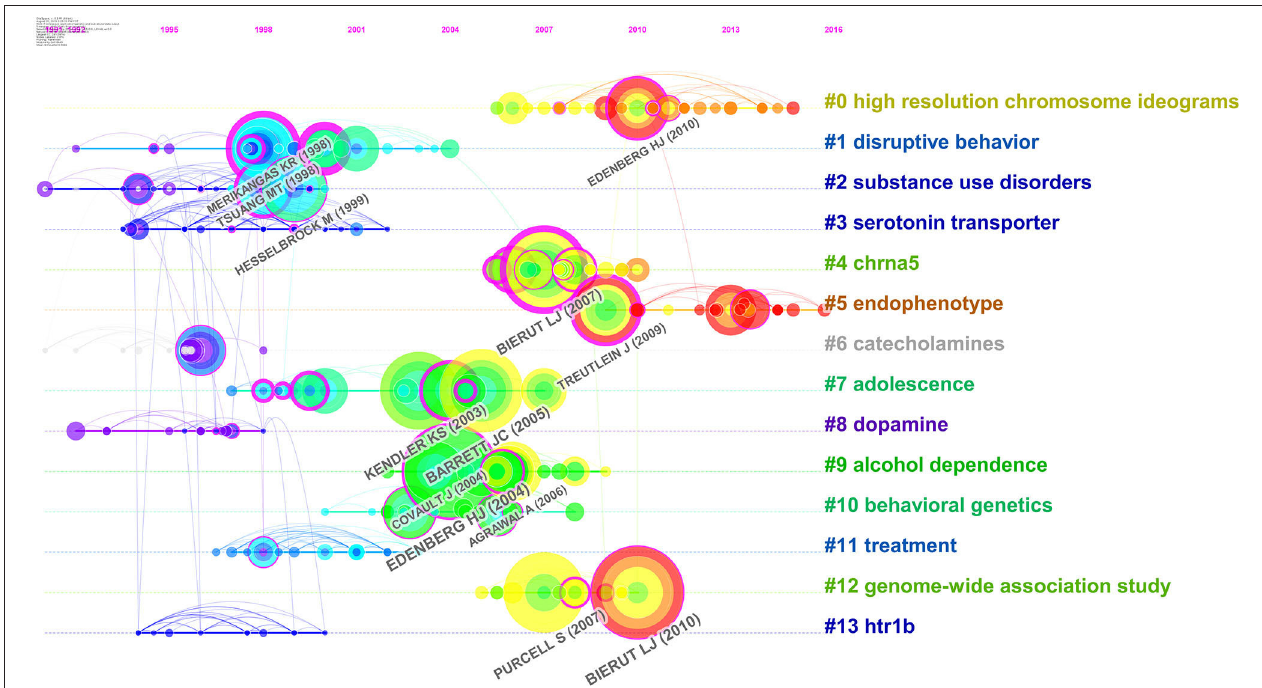
FIGURE 6 | Co-cited reference timeline map based on CiteSpace. Co-cited reference that is commonly cited in the substance-related disorders literature are clustered and identified by CiteSpace. Years are arranged horizontally at the top, and the label of each cluster is shown at the end of the cluster’s timeline.